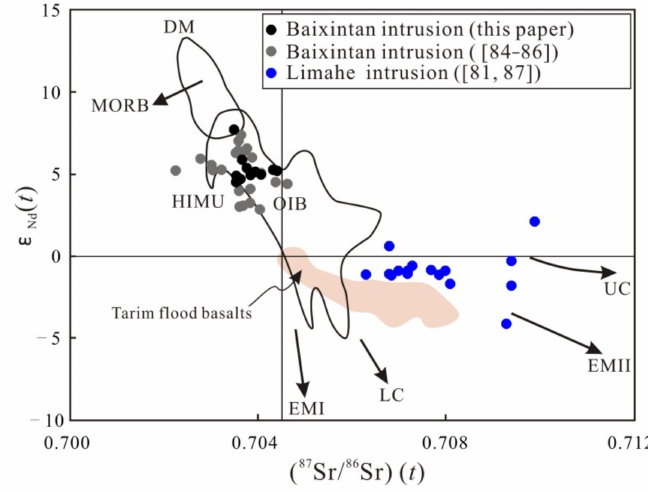
Figure 6. 87 Sr/ 86 Sr(t)- ε Nd(t) diagram (after [83]). Data sources of Baixintan: this paper, [84–86]; data sources of Limahe: [81,87];data sources of Tarim flood basalts: [88–90].